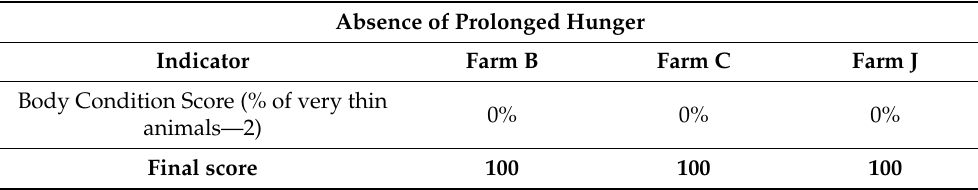
Table 9. Body Condition Score in the three farms using the WQ ® evaluation system.